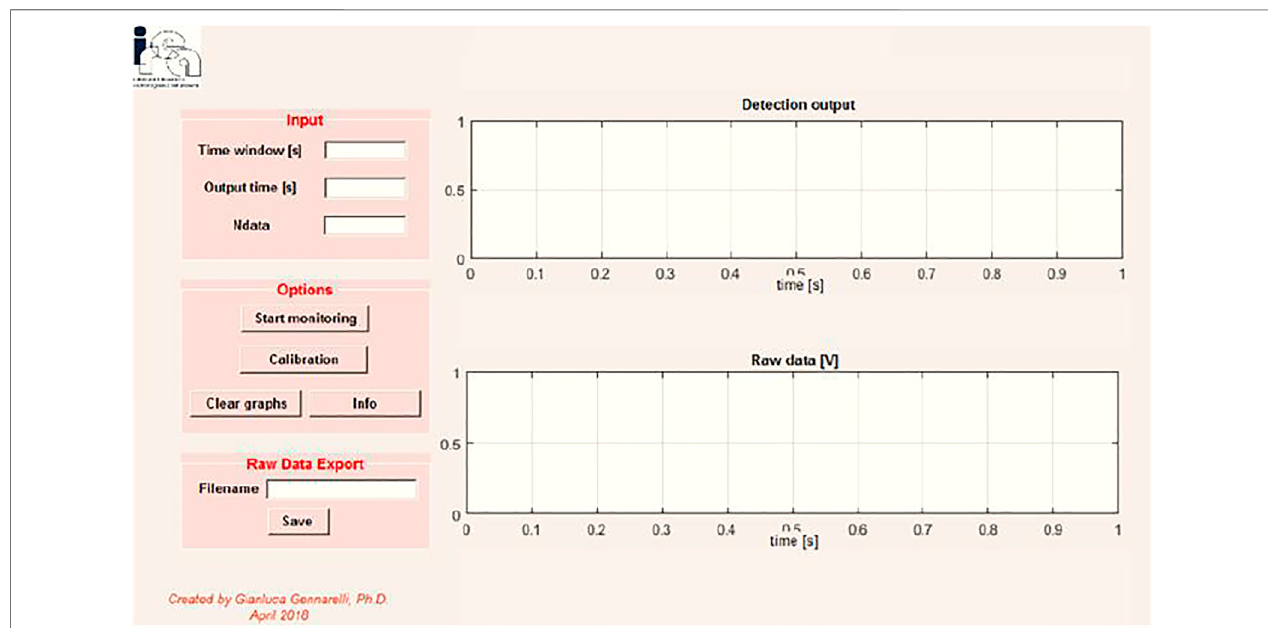
FIGURE 3 | MATLAB GUI for data processing, acquisition and